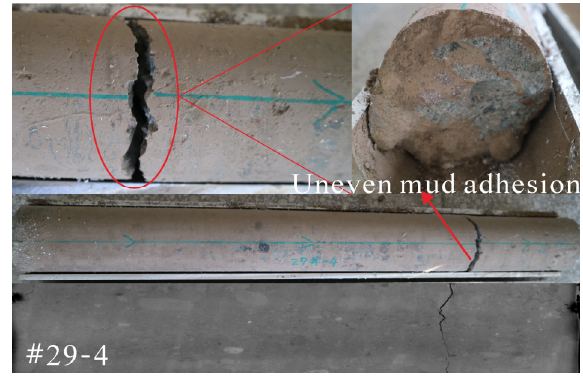
Figure 7. Features of a drilling-induced fracture.